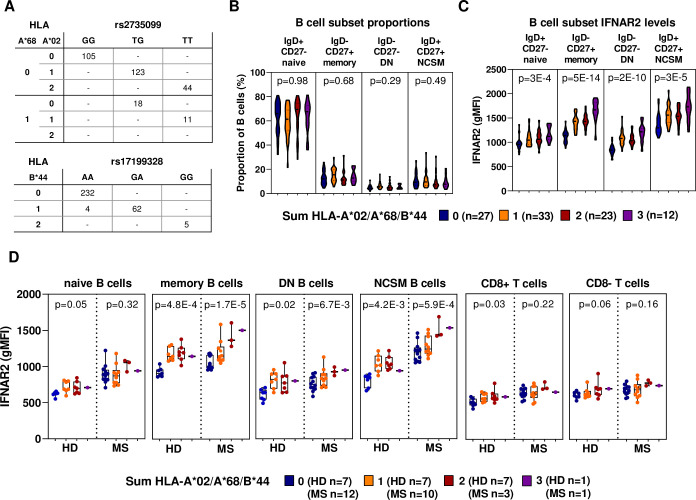
Increased IFNAR2 protein levels in B cells and T cells from carriers of the MS-protective class I alleles.(A) Correlation between rs2735099 and rs17199328 genotypes and imputed HLA-A (n = 301) and HLA-B alleles (n = 303). (B) The proportion of B cells subsets in bulk B cells (n = 95). (C) IFNAR2 surface levels in subsets of B cells from healthy donors (n = 95). (D) IFNAR2 surface levels in subsets of B cells and T cells from healthy donors (n = 22) and PwMS (n = 26). (B-D) Data are stratified by the sum of the MS-protective class I alleles HLA-A*02, HLA-A*68 and HLA-B*44, as indicated. p-values from the full model (B-C) or a simple linear regression (D), using the sum of MS-protective alleles (0–3) as a continuous variable. Boxplots show median, IQR and range. gMFI = geometric mean fluorescence intensity.